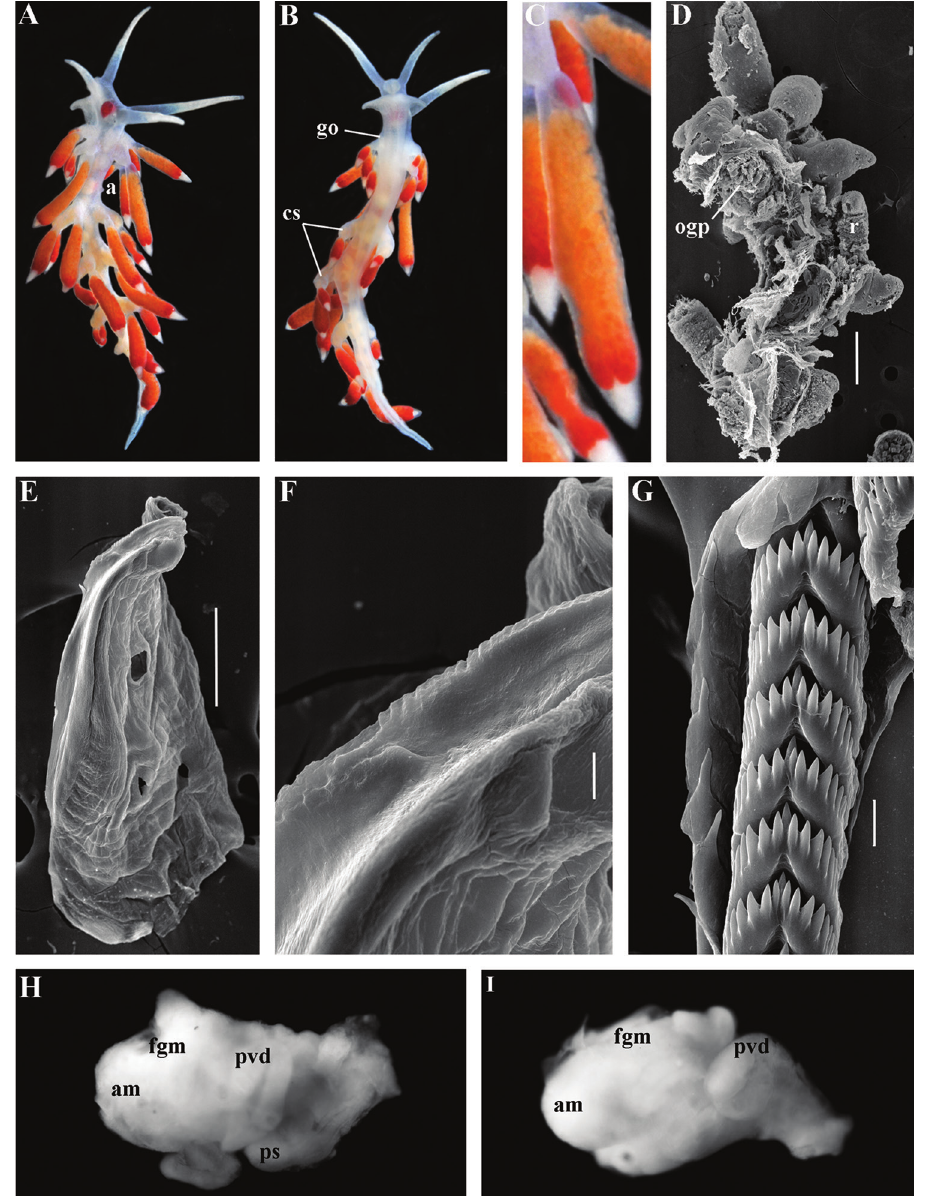
Figure 33. Calmella cavolini (Vérany, 1846). Mediterranean Sea, Banyuls-sur-Mer. ZMMU Op-485, liv- ing specimen 12 mm in length: A dorsal view B ventral view C details of cerata D dissected anterior part (pharynx removed) and rhinophores E jaw, SEM F details of masticatory process of jaw, SEM G radular teeth, posterior part, SEM H I reproductive system, light microscopy. Abbreviations: a anus am ampulla cs ceratal stalks fgm female gland mass go genital opening ogp oral gland penetrating into basis of cerata r rhinophores ps penial sheath pvd prostatic vas deferens. Scale bars: D, E = 300 μm; F, G = 10 μm. Photos and SEM images by T.A. Korshunova, A.V.